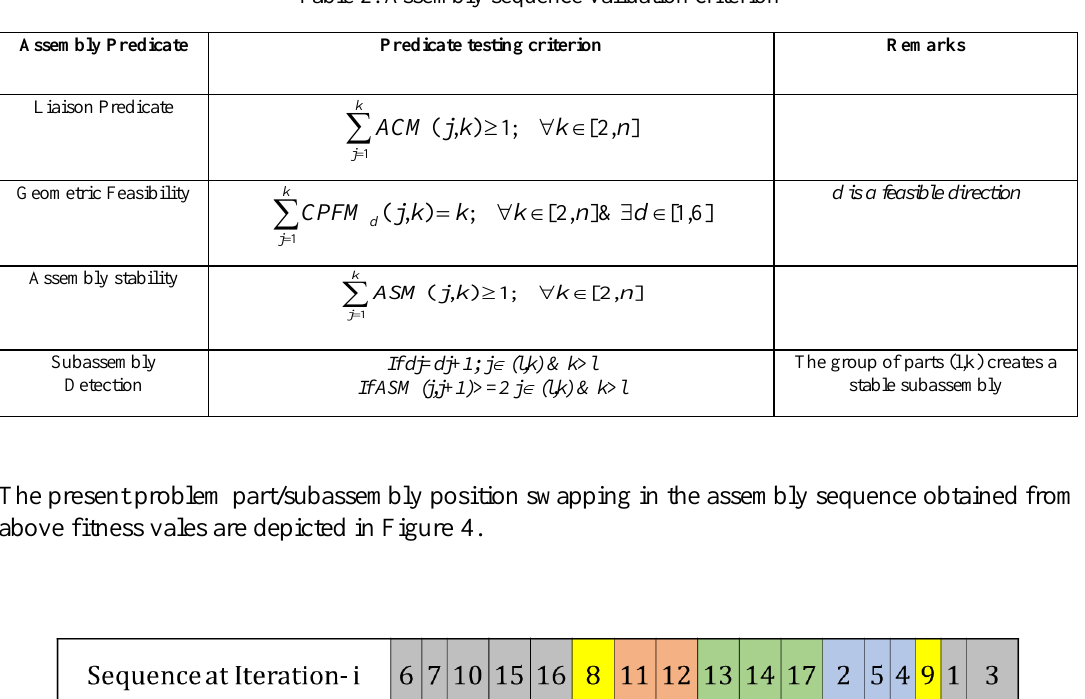
Table 2. Assembly sequence validation criterion